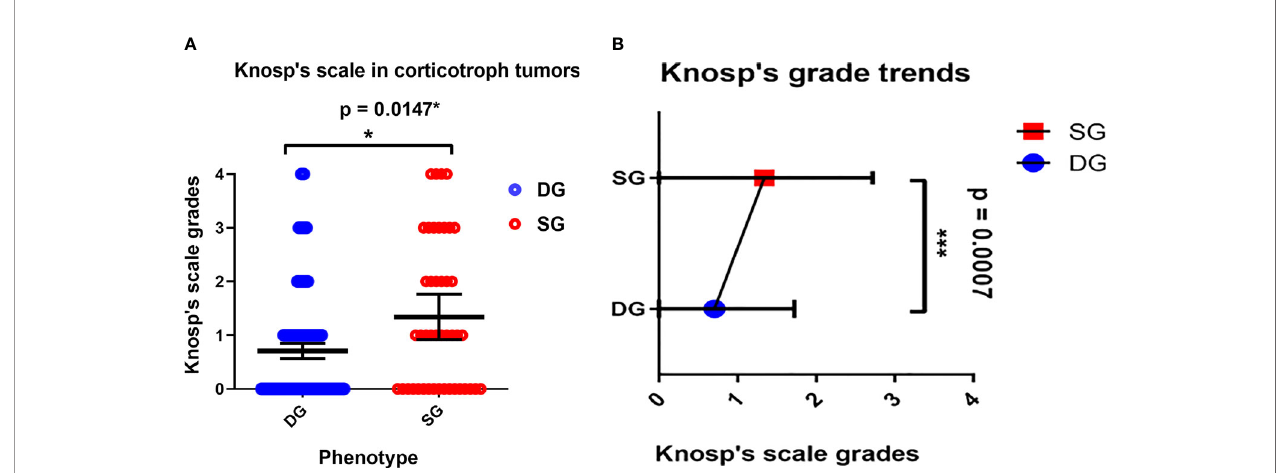
FIGURE 3 | (A) The Distribution of DG and SG subtypes in corticotroph tumors according to the Knosp ’ s scale grades. Blue circles represent single cases of DG corticotroph tumors, and red circles SG corticotroph tumors. Calculated according to Chi² test (p = 0.0147*). The error bars show mean with 95% CI. (B) The overall trend among all corticotroph PitNETs exhibits higher Knosp ’ s scale grades among SG corticotroph tumors. Blue color represents mean with 95% CI for DG corticotroph tumors and red color for SG corticotroph tumors. Calculated according to Chi² test for trends p =